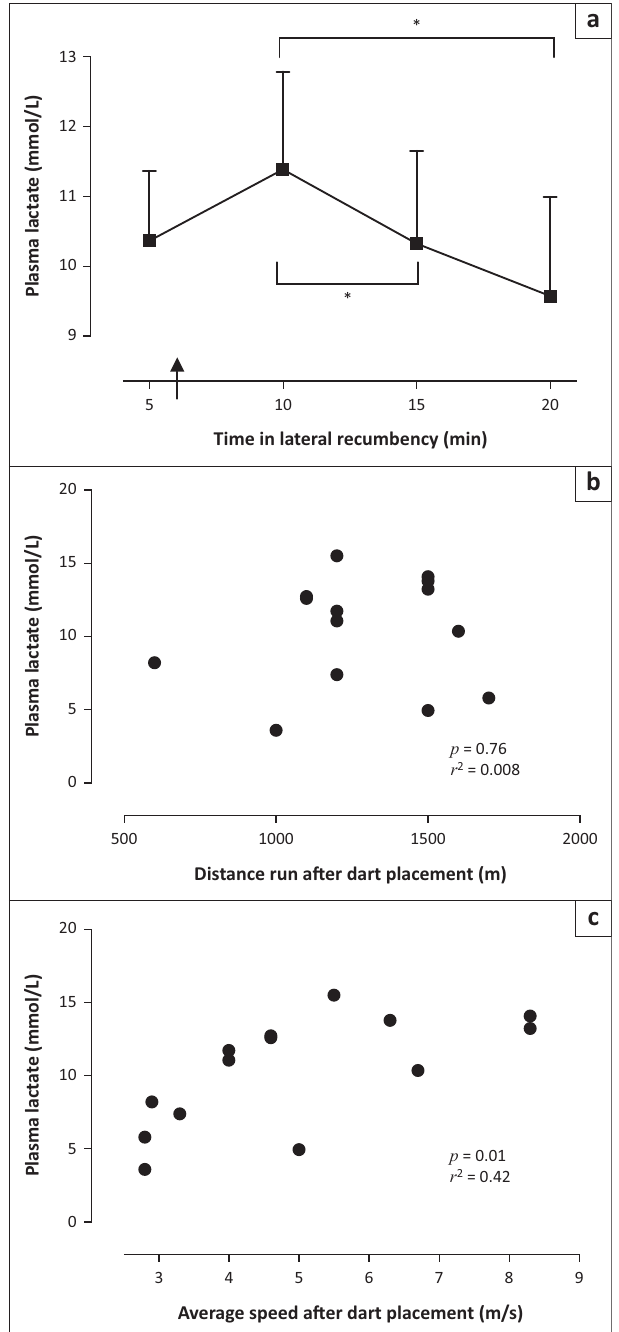
) in immobilised white rhinoceroses. 3